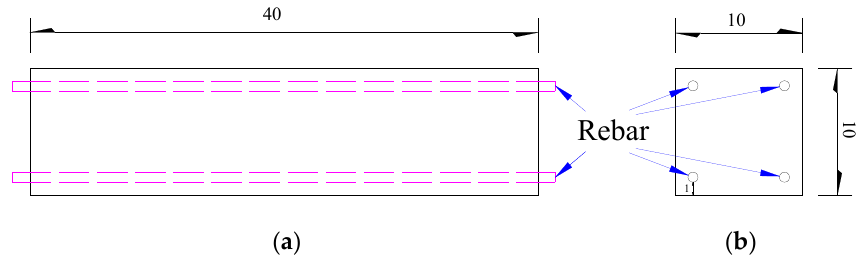
Figure 1. Sketch of test specimen (unit: cm): ( a ) Front view; ( b ) lateral view.